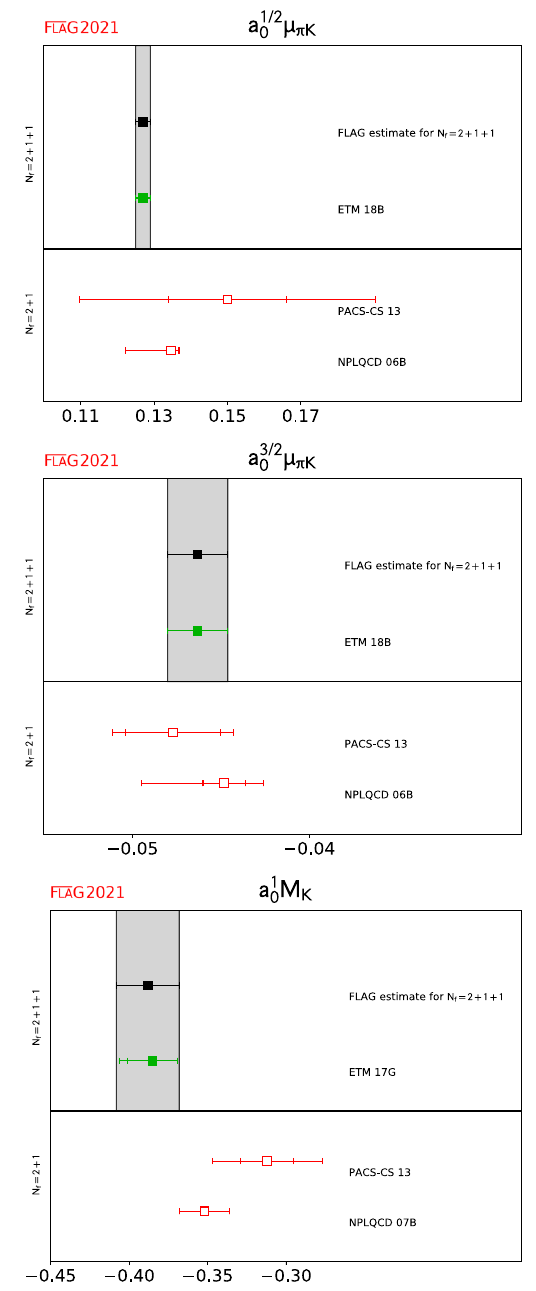
/ 2 3 / 2 μ π μ π K (top), a K (middle) and of the K K scattering length a 0 0